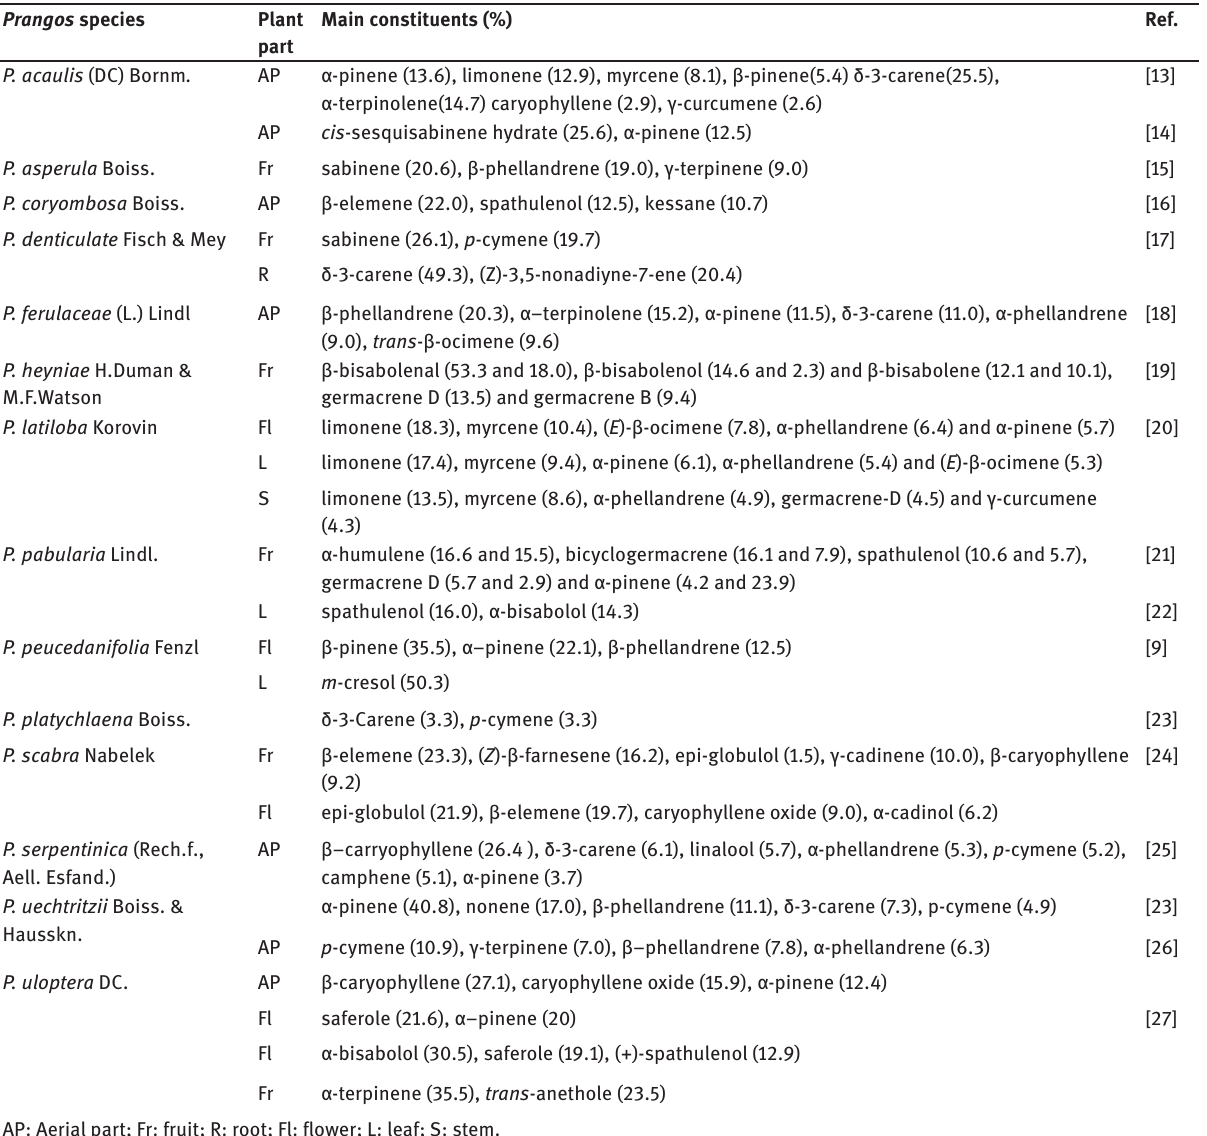
Table 2: The main compounds detected in EOs of Prangos species (literature survey). Prangos species